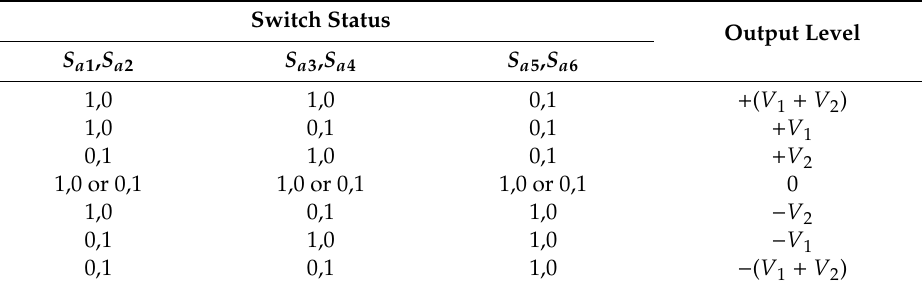
Table 1. Switching states of the seven-level topology.